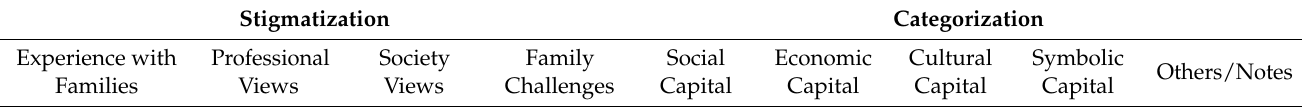
Table 2. Matrix of the themes.